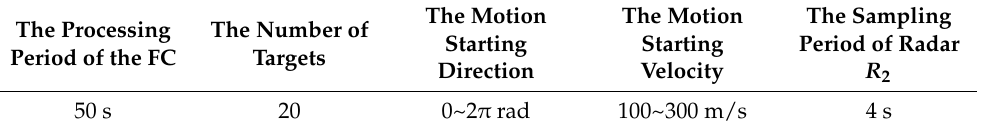
Table 2. The parameter settings for simulation scenario